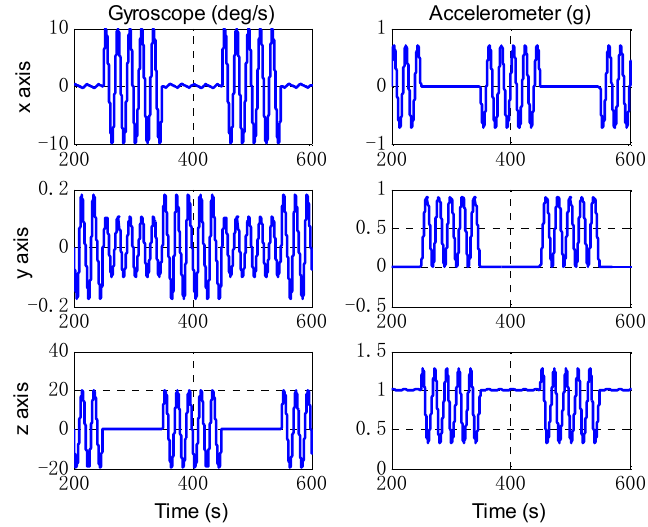
Figure 8. The IMU outputs of angular motion simulation. The left three figures are the angular rate measured by gyroscopes, the right three figures are the specific forces measured by accelerometers.